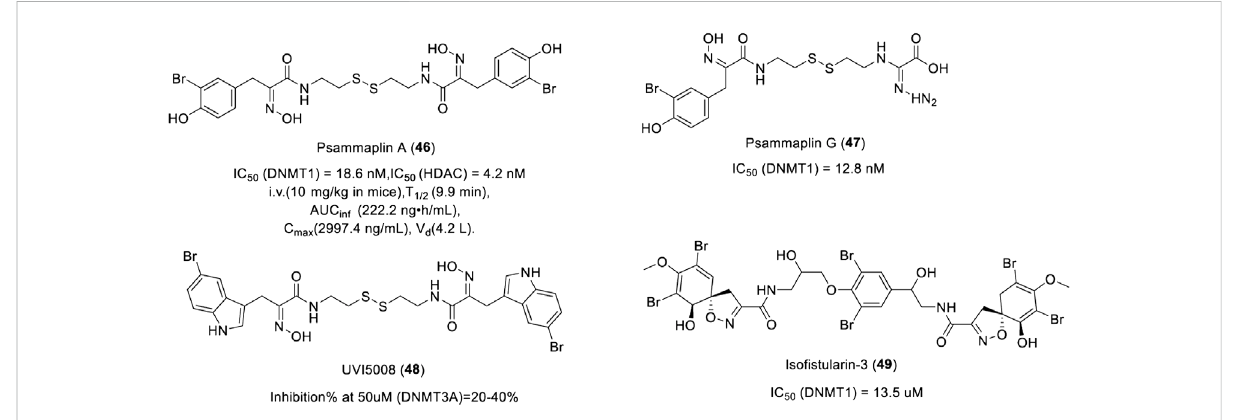
FIGURE 9 Chemical structure of bromotyrosine-based DNMTis in pre-clinical.